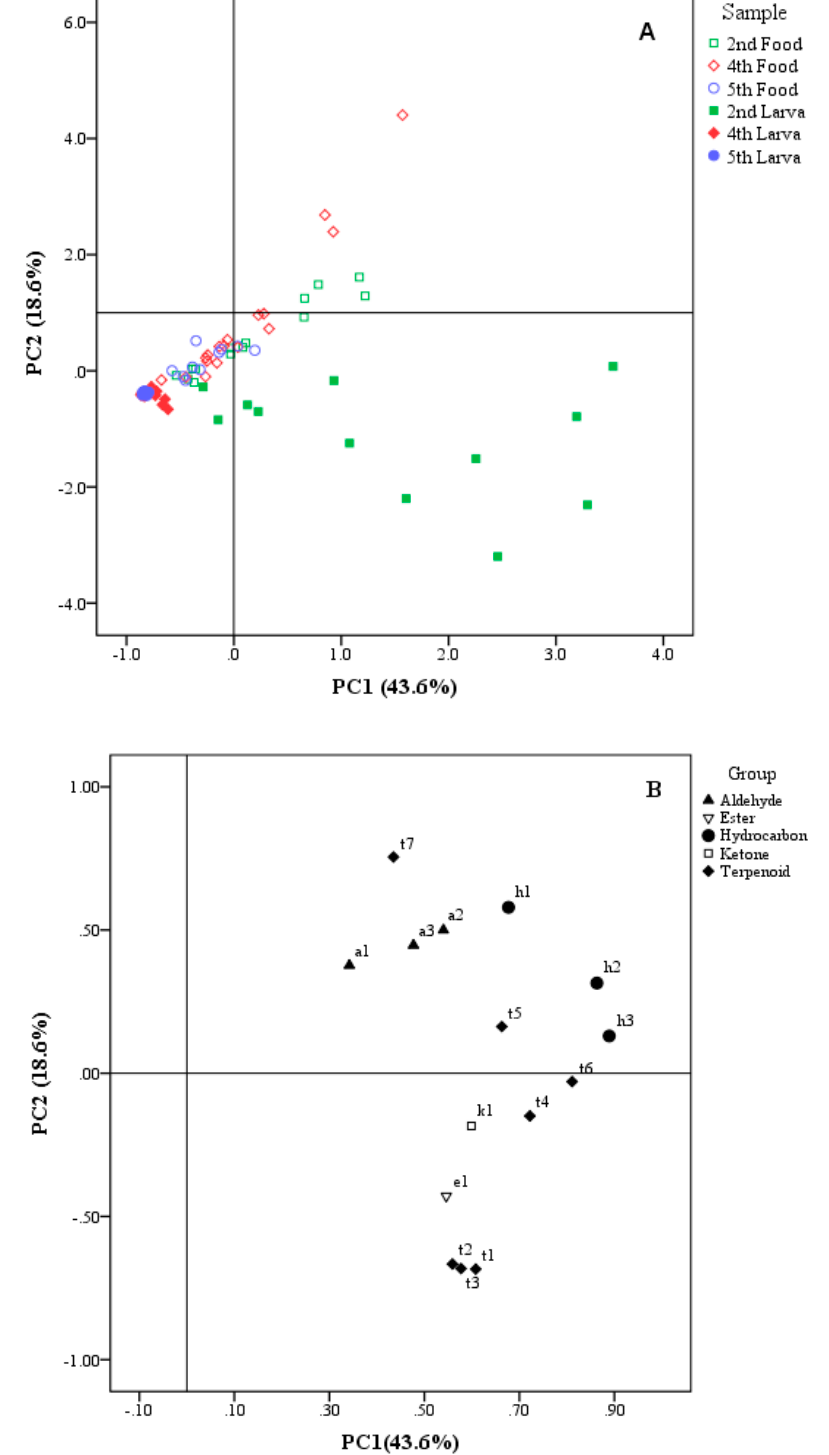
Figure 5. Positions of PC scores of samples including larvae and larval food at different larval instars (2nd: 2nd instar, 4th: 4th instar, and 5th: 5th instar). ( A ): Scores scatter plot of principal component analysis (PCA). ( B ): Loadings plot of PCA. The codes in ( B ) correspond to the compound codes listed in Table 1.